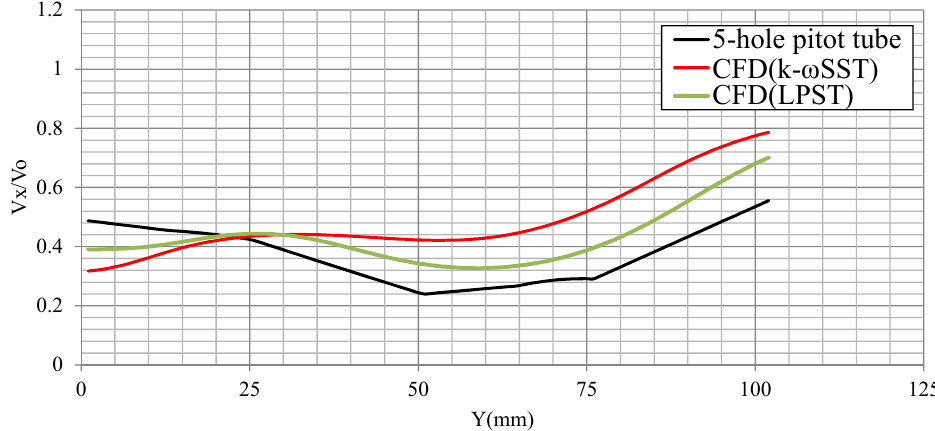
Figure 17. Axial velocity distribution of KVLCC2 along the horizontal line above propeller shaft.